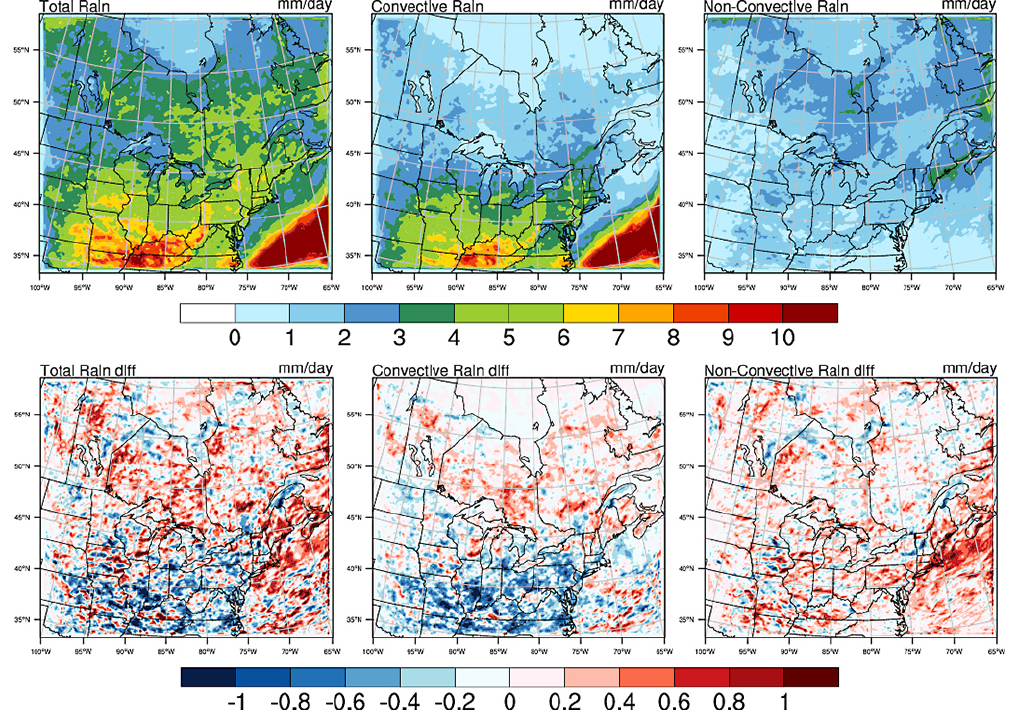
Figure 4. Spatial distribution of five month mean (April–August, 2009) simulated total daily precipitation (left), convective (centre) and non-convective rain (right) by WRF/Chem (top) and the difference (WRF/Chem – WRF)